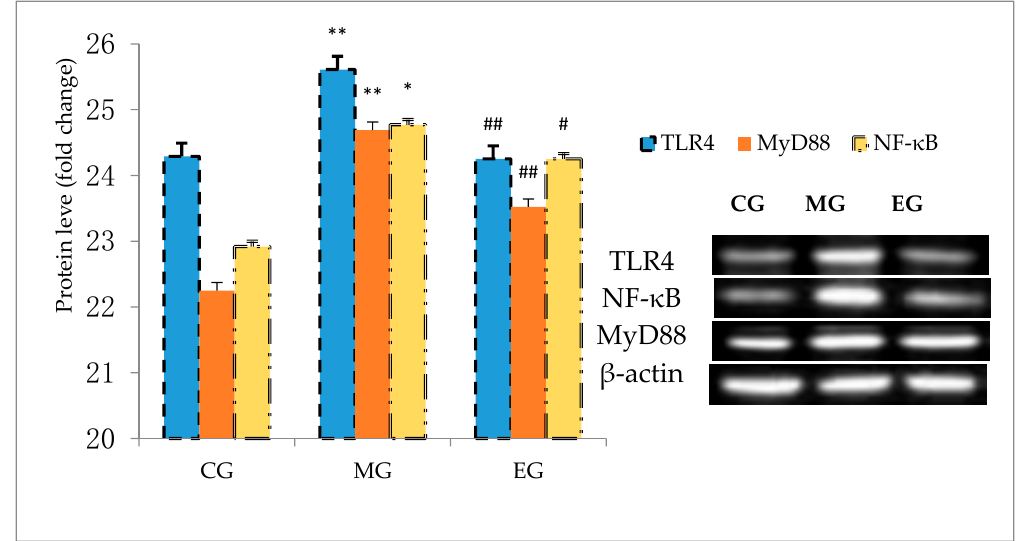
Figure 7. Changes of TLR4, MyD88, and NF- κ Bp65 expression of the hippocampus of each group. The results of expression of the TLR4, MyD88, and NF- κ B65 of the mice of the 3 goups are presented as the means ± SD. The internal reference was the β -actin protein. ** p < 0.01, * p < 0.05, versus control group, ## p < 0.01, # p < 0.05, versus model group (one-way ANOVA followed by the Kruskal–Wallis test).